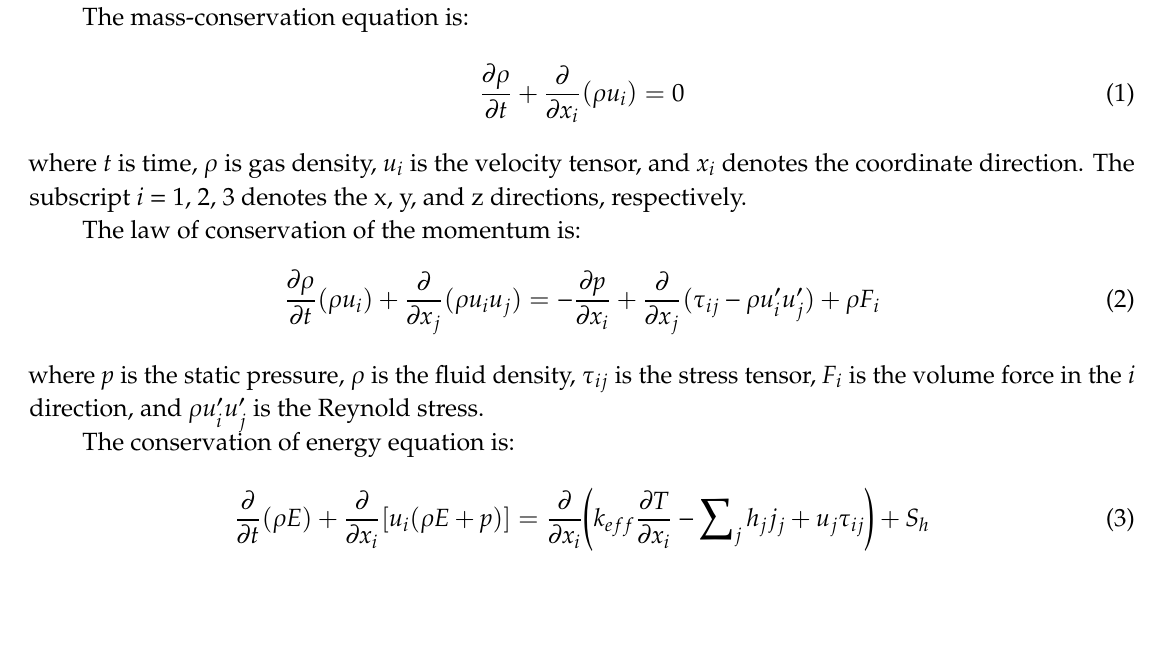
Figure 2. 3D model of a check valve.